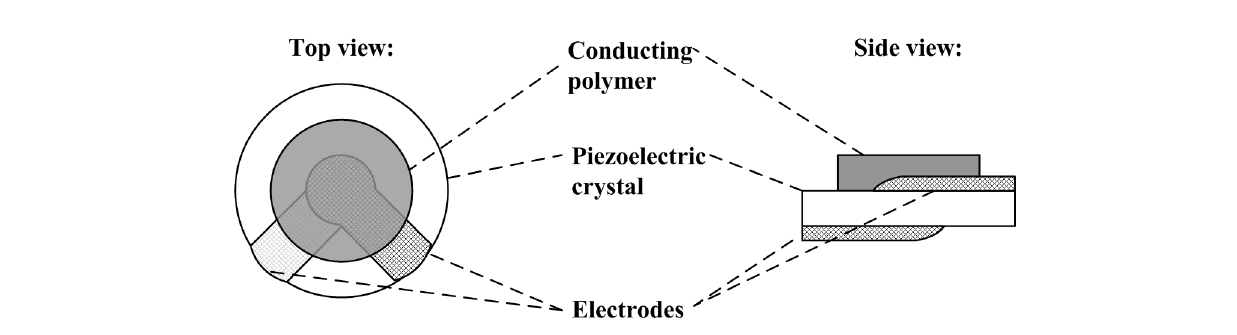
Figure 10. Configuration of quartz crystal microbalance sensor device.